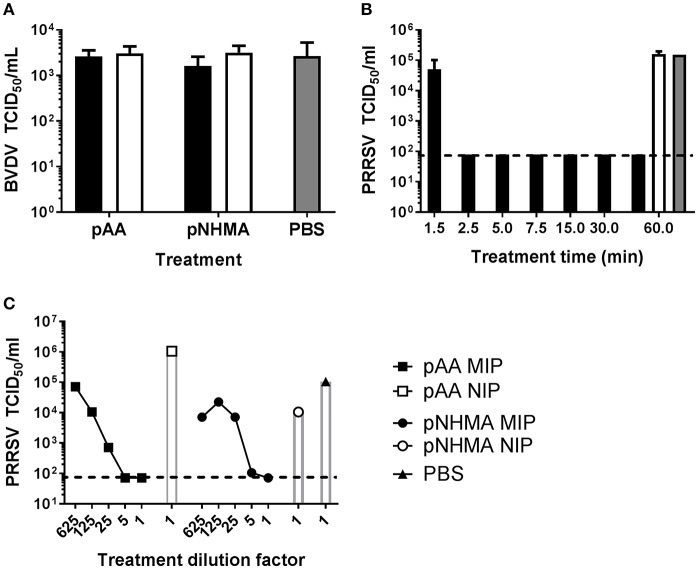
Characterization of the virus neutralizing properties of hydrogel MIPs. The specificity of PRRSV-1 virus-imprinted MIPs was assessed by evaluating neutralization of BVDV-1 (A). A suspension of BVDV-1 was incubated for 1 h with pAA or pNHMA MIPs (closed bars). Non-imprinted polymers (NIPs; open bars) and PBS (gray bars) were included as negative controls. To assess the effect of incubation time on PRRSV-1 neutralization by MIPs, a suspension of PRRSV-1 was incubated for 60, 30, 15, 7.5, 5, 2.5, and 1.5 min with pNHMA MIPs (closed bars) (B). Sixty minute incubation with NIPs (open bar) and PBS (gray bar) were included as negative controls. To assess the effect of MIP concentration PRRSV-1 neutralization by MIPs, a suspension of PRRSV-1 was incubated for 1 h with a 5-fold serial dilution of pAA or pNHMA MIPs, a neat suspension of NIPs or PBS (C). After incubation, MIPs/NIPs were removed and the infectious viral titers in supernatants determined by immunoperoxidase staining of inoculated cell monolayers. The mean infectious titers, expressed as 50% tissue culture infectious doses (TCID50), for technical triplicates of each treatment condition are presented and error bars represent the standard error of the means. The limit-of-detection of the assays are indicated by horizontal dashed lines.